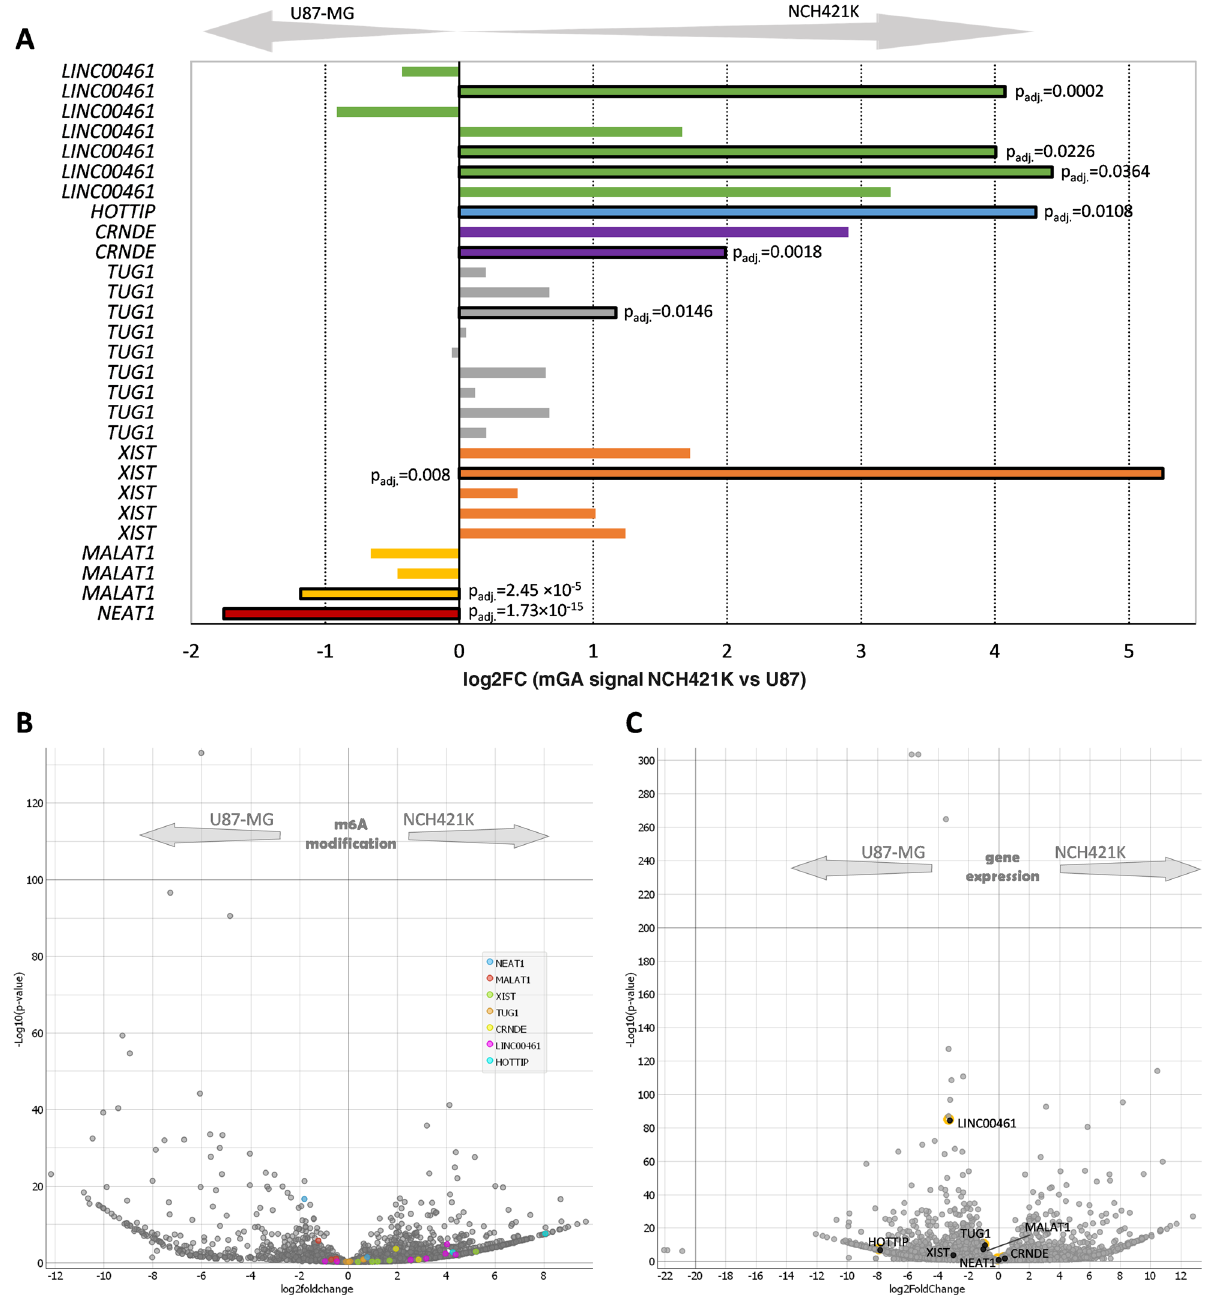
Figure 4. Glioma associated lncRNAs m6A modification ( A ) Bar plot of glioblastoma associated lncRNAs m6A peaks log 2 FC detected by MeRIP-seq in NCH421K and U87-MG. Note that multiple peaks map to the same gene. Bars with solid black border represent significantly enriched peaks (Benjamini–Hochberg adjusted p < 0.01). ( B ) Volcano-plot showing m6A peaks in glioma associated lncRNAs (colored dots) in the context of all detected lncRNAs . ( C ) Volcano-plot of glioma associated lncRNAs expression (calculated at gene level) in the context of all detected lncRNAs. Screened out lncRNAs indicated in black dots with yellow